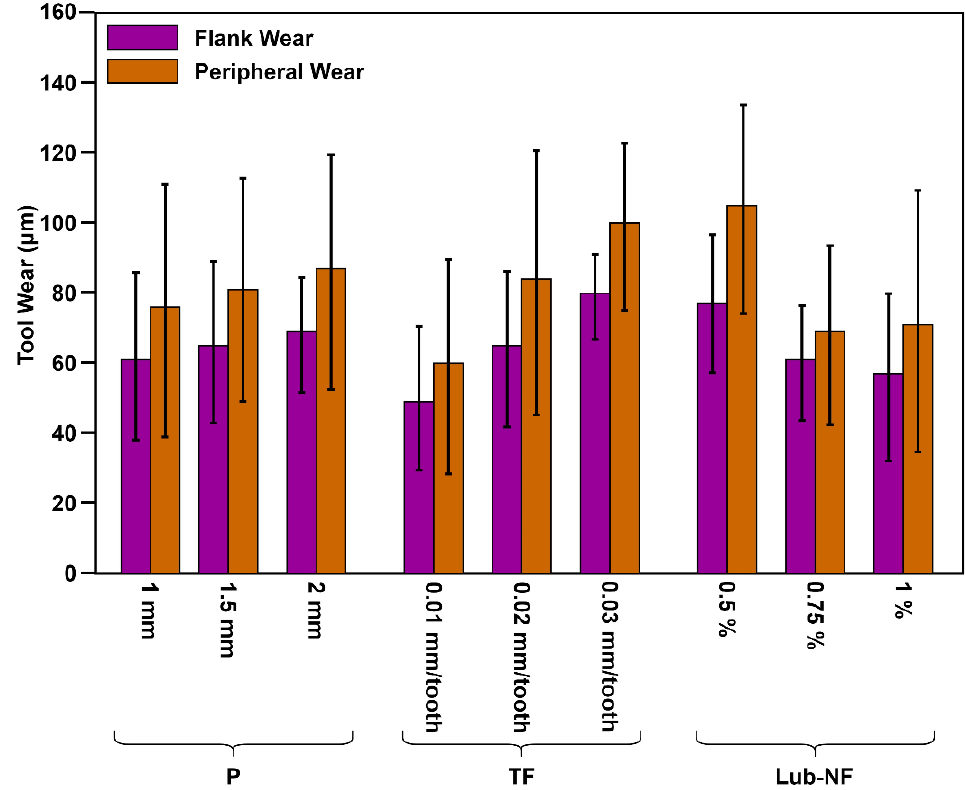
Figure 15. Parametric trends (pitch, tangential feed, and lubrication) of tool wear during hole-making in CFRP/Ti6Al4V.